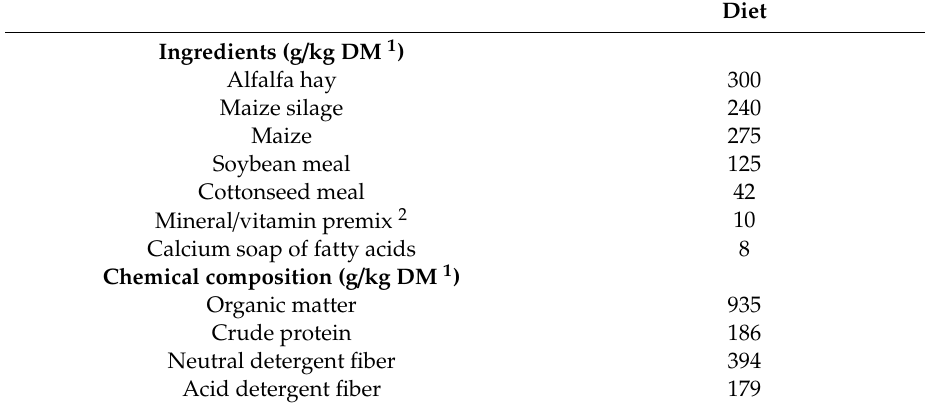
Table 1. Ingredient and chemical composition of diet fed to ruminal content donor